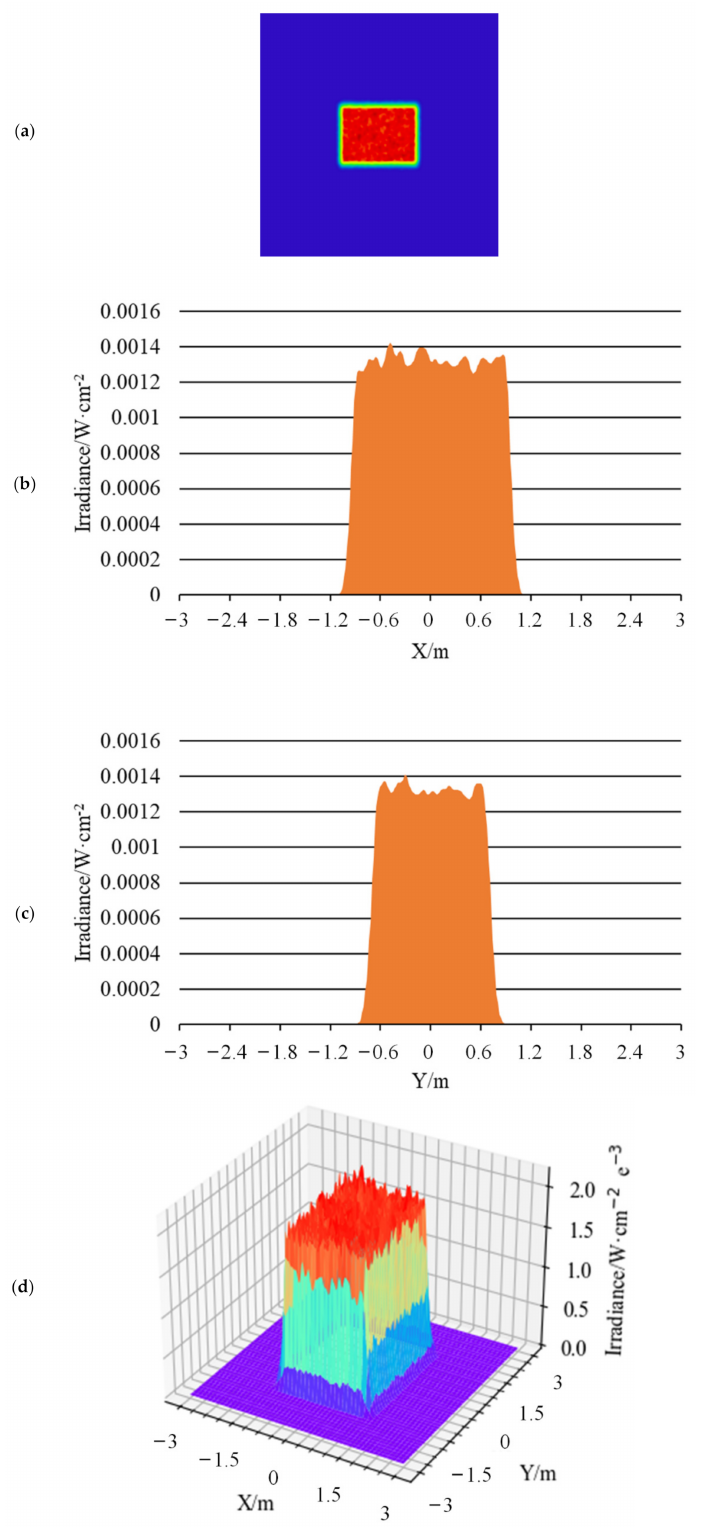
Figure 21. Laser spot and energy distribution at distance of 120 m: ( a ) Light spot; ( b ) Energy distribution in the horizontal direction; ( c ) Energy distribution in the vertical direction; ( d ) 3D energy